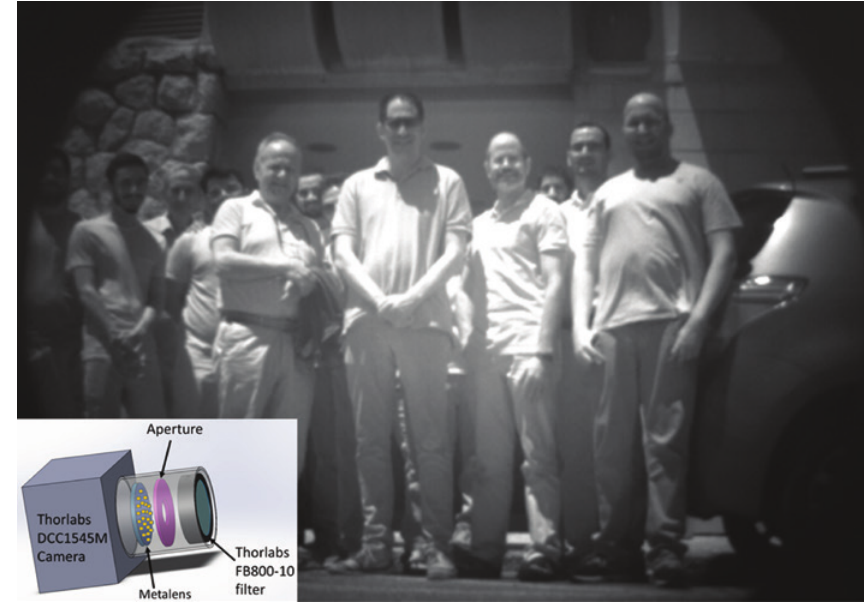
Figure 6: Metalens outdoor